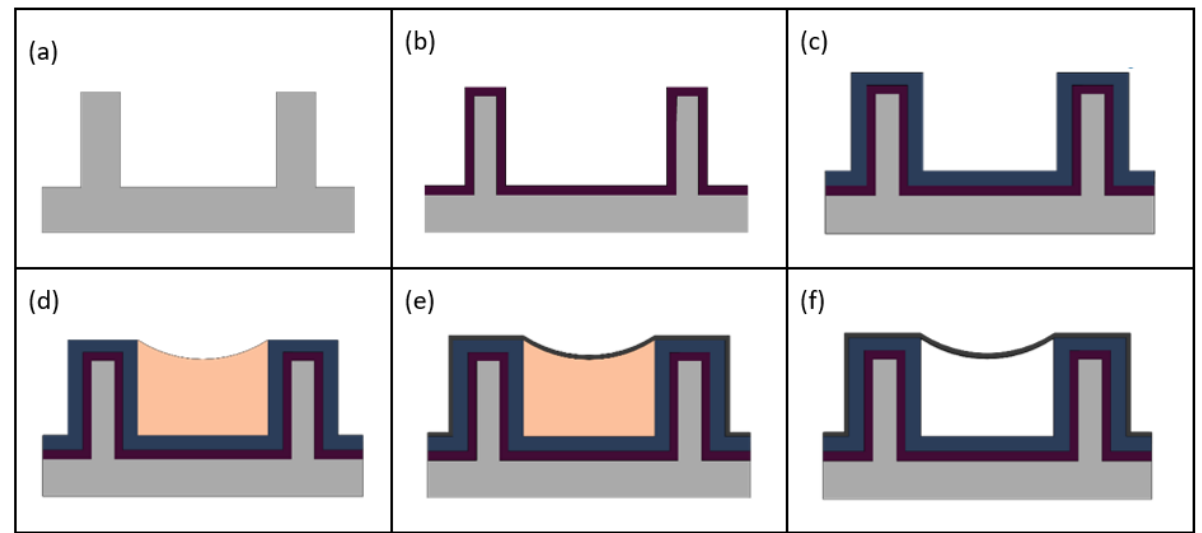
Figure 2. Fabrication flow diagram. ( a ) Microfluidic side walls are etched into silicon substrate. ( b ) Thermal oxidation converts silicon into silicon dioxide. ( c ) High index PECVD silicon dioxide is grown for SC waveguides as shown in Figure 2. ( d ) SU8 2000.5 is introduced into the channels by way of spontaneous capillary action. ( e ) A silicon dioxide membrane is formed by PECVD deposition. ( f ) SU8 2000.5 is sacrificially etched, leaving an intact membrane covering a hollow-core channel.